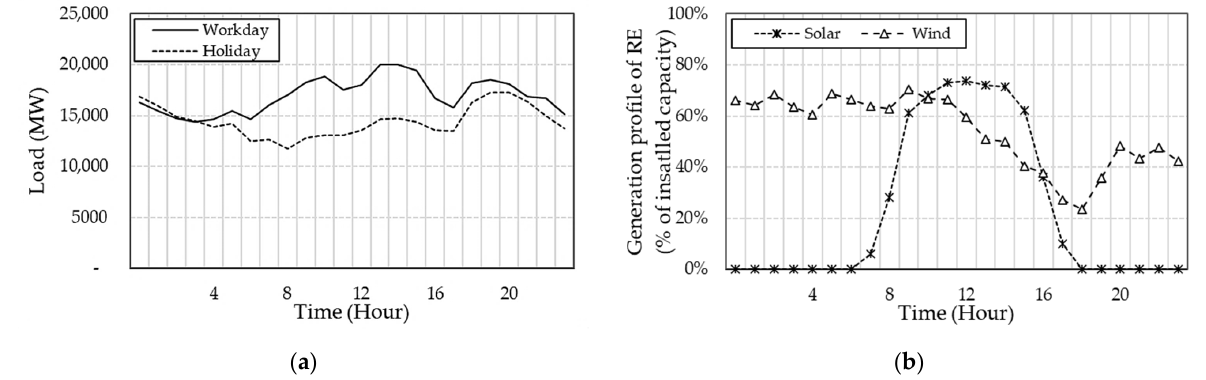
Figure 4. ( a ) Load profiles of workdays and holidays. ( b ) RE generation profiles [40].